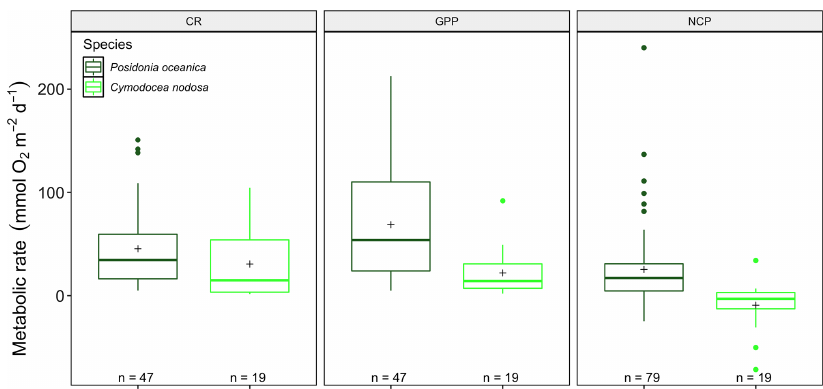
Figure 4. Metabolic rates for GPP, CR and NCP (mmolO 2 m − 2 d − 1 ) for Cymodocea nodosa (light green) and Posidonia oceanica (dark green) for the benthic chambers dataset in the western Mediterranean basin. Upper and lower hinges correspond to the upper and lower quartiles; the line inside the boxes corresponds to the median; the mean is marked by a crosshair; and the error bars are based on minimum and maximum standard deviation for each parameter (rates were different between species with p < 0 . 001 for GPP and p < 0 . 01 for CR).